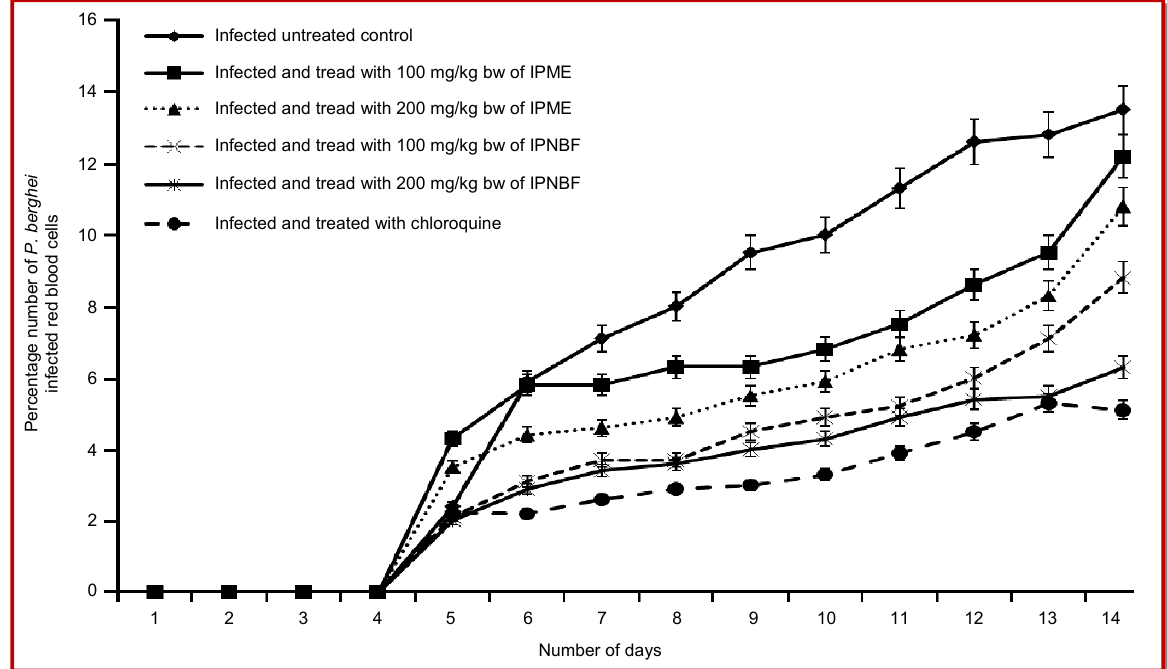
Figure 1: Effect of I. pulchra leaves extracts on the course of P. berghei infection in mice. All Data are presented as mean ± SD. IPME and IPNBF means methanolic extract and n -butanol fraction of I. puchra leaves